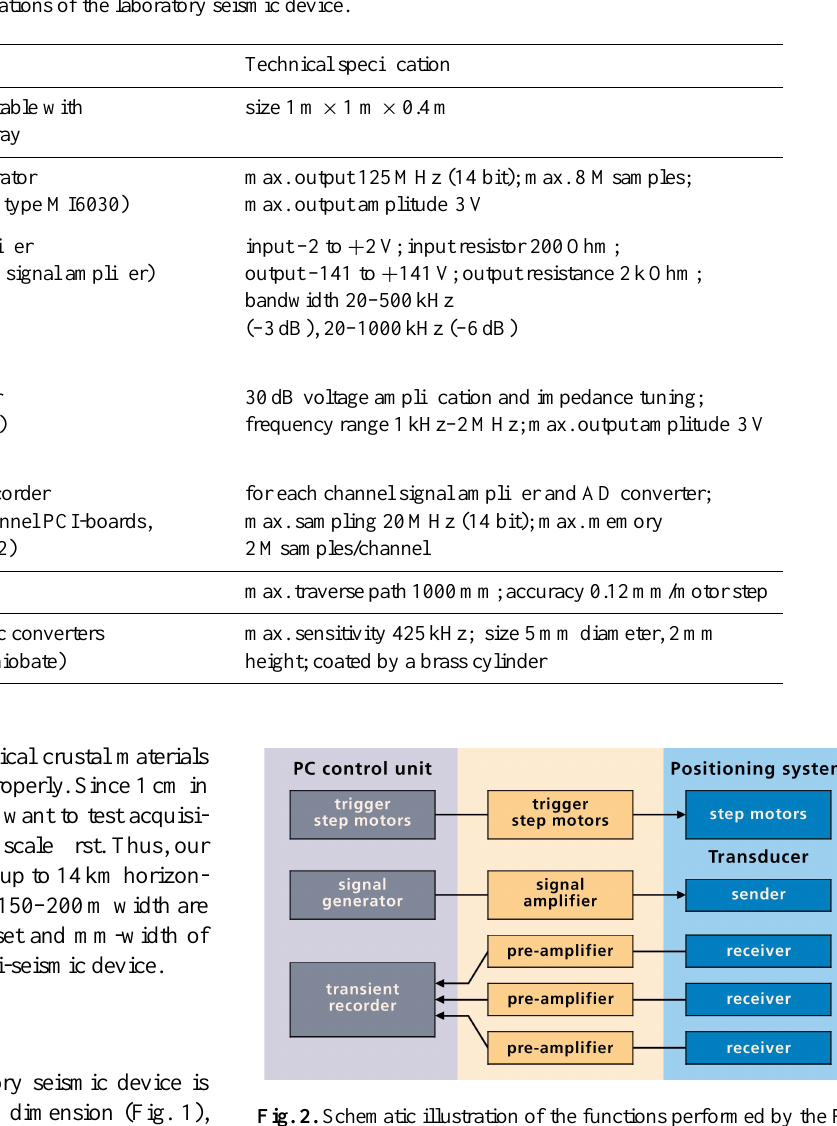
Fig. 2. Schematic illustration of the functions performed by the PC control unit for communication with the positioning system and the